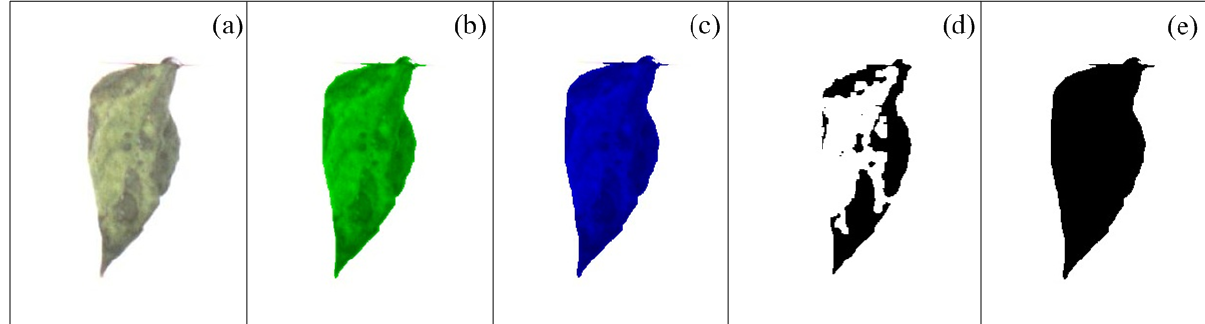
Figure 7. Bean leaves with necrosis. ( a ) Necrotic bean leaf in RGB format. ( b ) Green component of the necrotic bean leaf. ( c ) Blue component of the necrotic bean leaf. ( d ) Necrotic leaf area segmentation. ( e ) Total leaf area